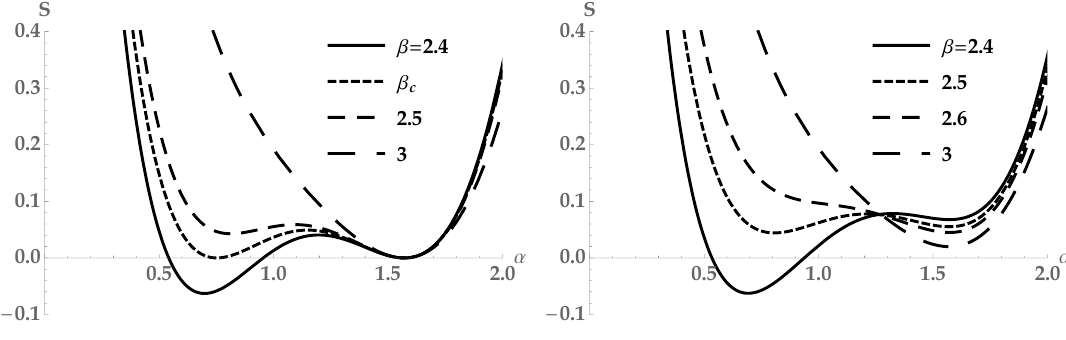
Figure 3 . The action S in (4.8) for the U(2) theory as a function of the eigenvalue (cid:11) = (cid:11) 1 = (cid:0) (cid:11) 2 . The left plot is for one and the right plot is for ten harmonics included in